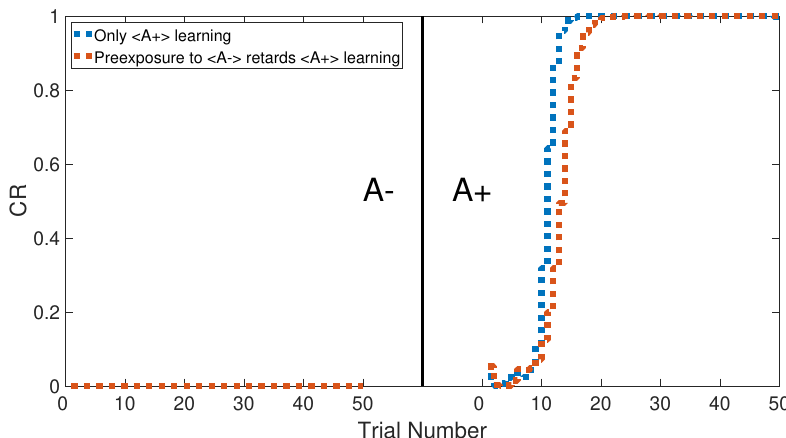
Figure 26. Generic feedforward multilayer network compared to the CHCQ lesioned system.